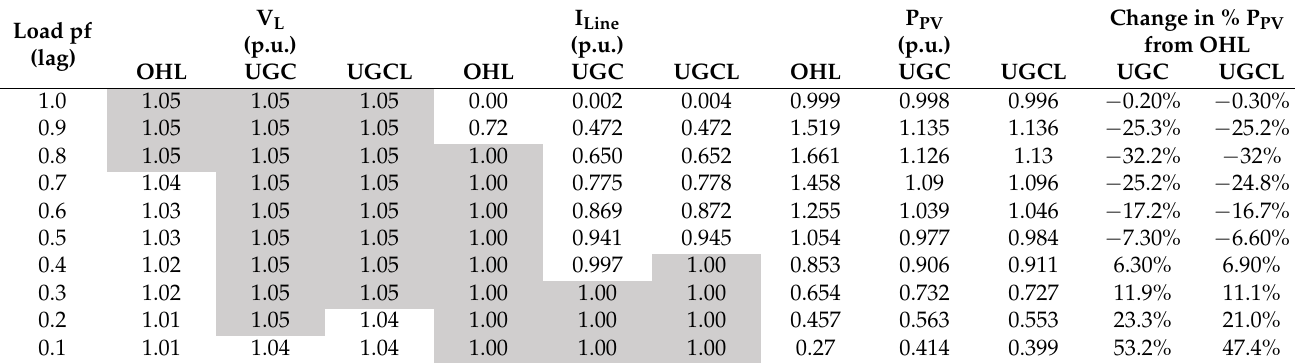
Table 6. Changing the load power factor for the different feeders (Substation voltage 𝑉 𝑆 = 1.05 p.u. ) .